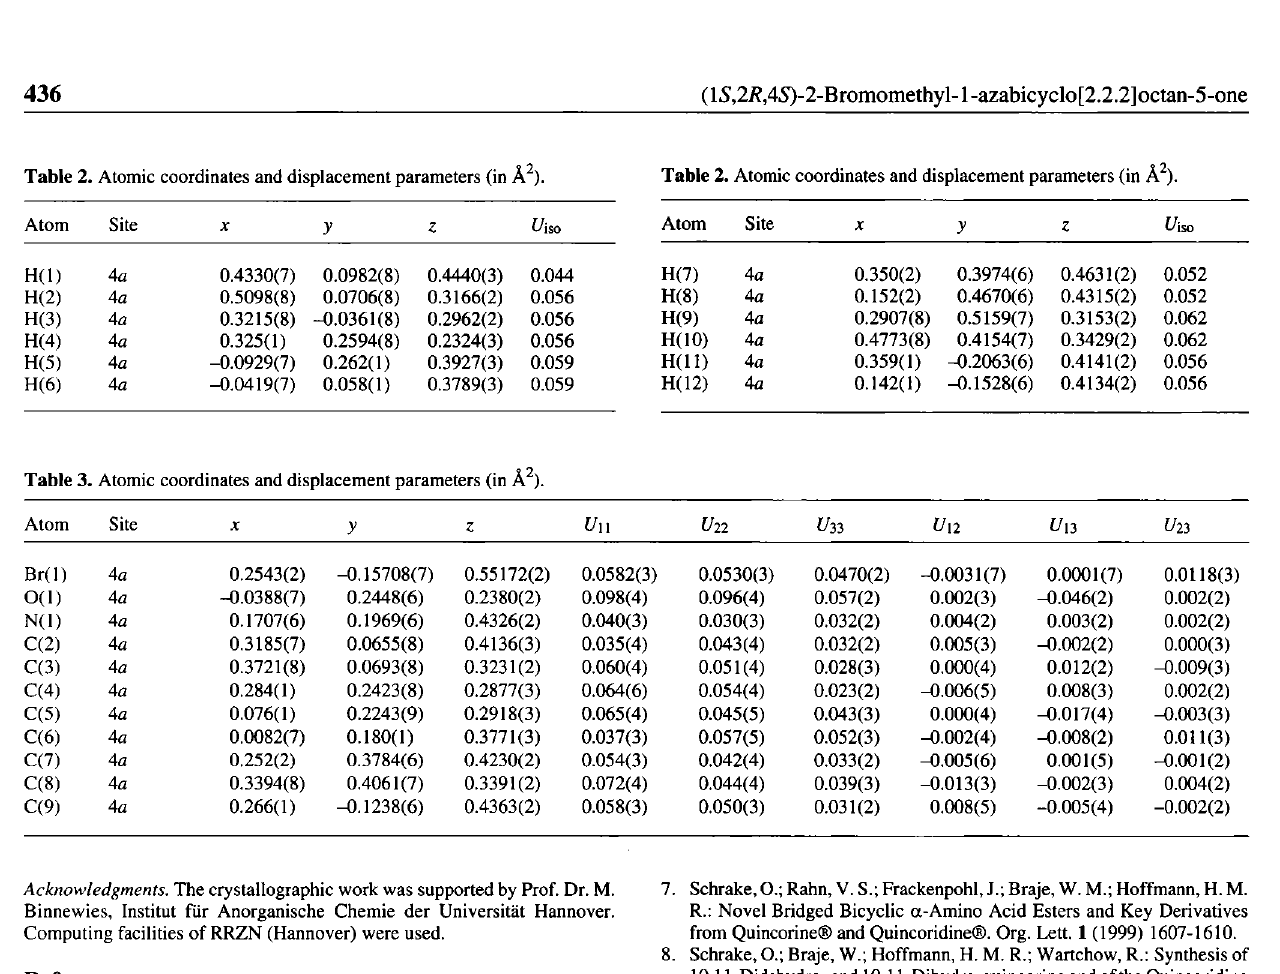
Table 2. Atomic coordinates and displacement parameters (in Ä 2 ).